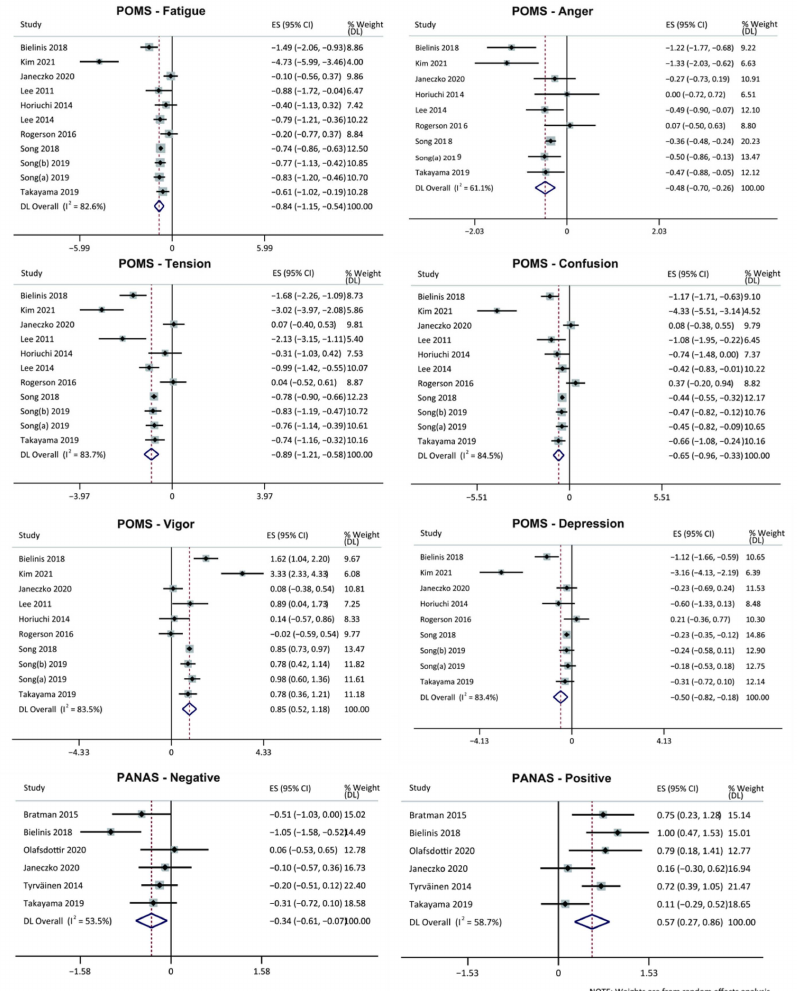
Figure 4. Forest plot of the meta-analysis of the relationship between green space exposure interven- tion and psychological indicators. Note. This forest plot depicts the meta-analysis results derived from the random effects model. In the case of POMS-Fatigue, the pooled effect size was − 0.84, with a 95% confidence interval of − 1.15 to − 0.54. It shows that the experimental group’s Fatigue score was 0.84 lower than the control group’s and that the difference was statistically significant, p = 0.019 < 0.05 (Table A5). This demonstrates that a short-term green space intervention can reduce fatigue signif- icantly. ES = effect size; I 2 = extent of heterogeneity in effect size across studies; CI = confidence interval; POMS: Profile of Mood States; PANAS: Positive and Negative